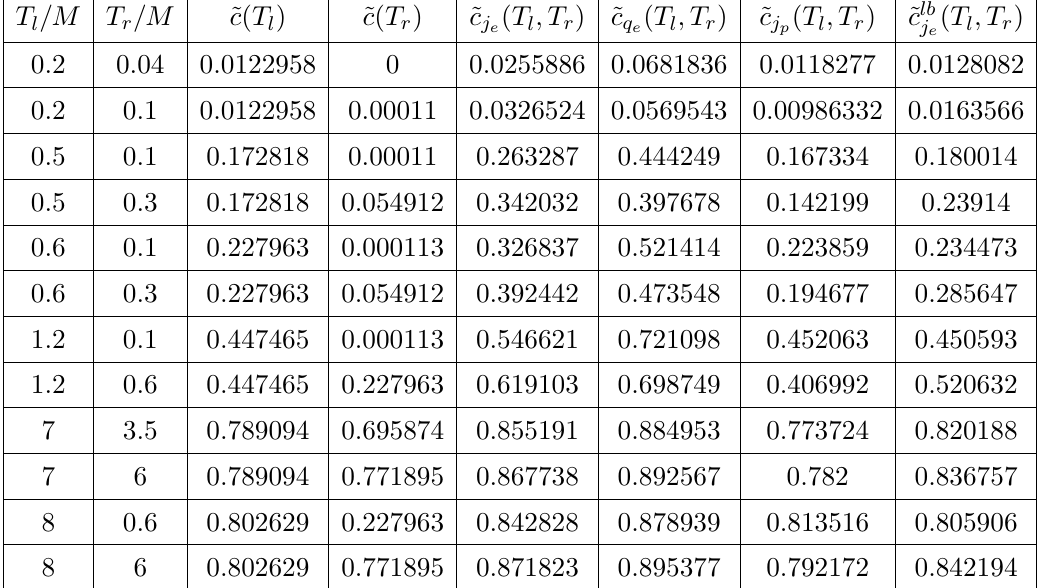
Table 4. The e(cid:11)ective central charges for (left and right) thermal states and the dynamical central charges for the partitioning protocol for various left and right temperatures in the massive sinh- Gordon theory with B = 0 : 5, where c UV = 1 and c IR =